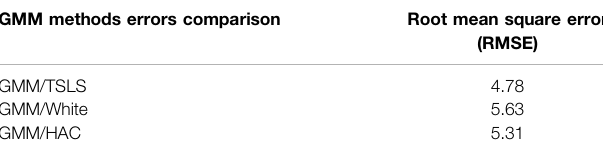
TABLE 7 | GMM root mean square error results of